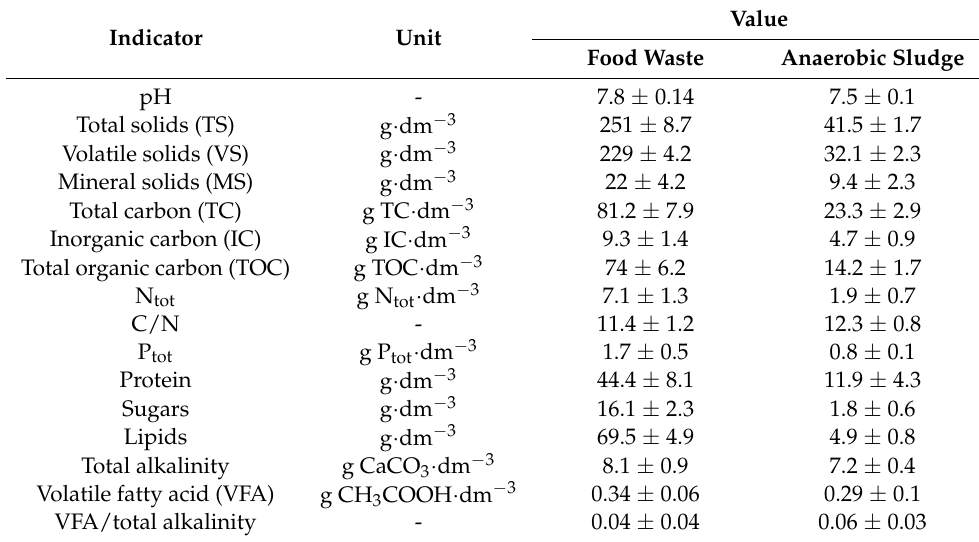
Table 1. Properties of the food products and anaerobic